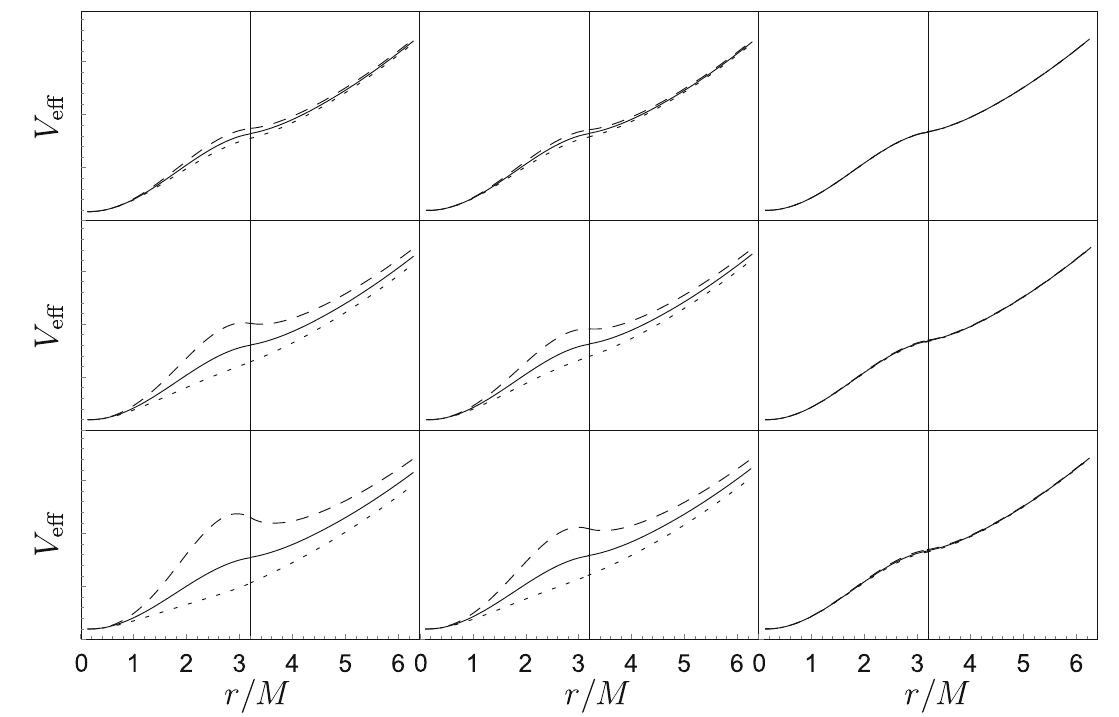
( λ = λ + and λ = λ − respectively). The first column is for θ = π/ 2, the second is for θ = π/ 4 and the last is for θ = 1 / 100. The first row is for j = 0 . 1, the second is for j = 0 . 4 and the last is for j = 0 . 7